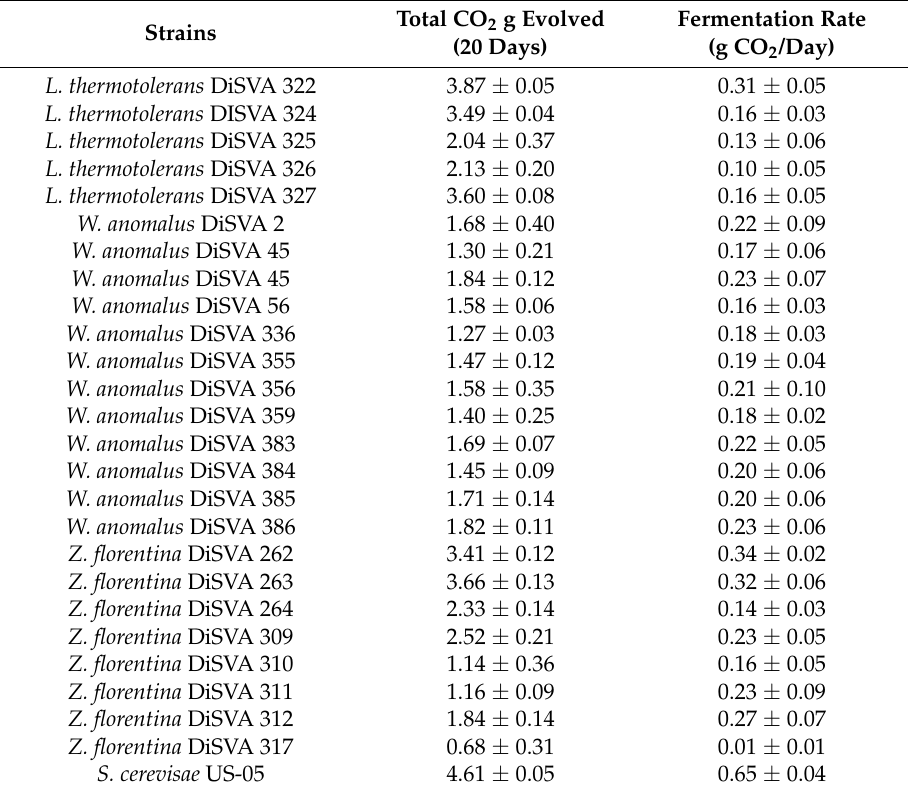
Table 1. Fermentation parameters of different non-conventional yeasts on malt